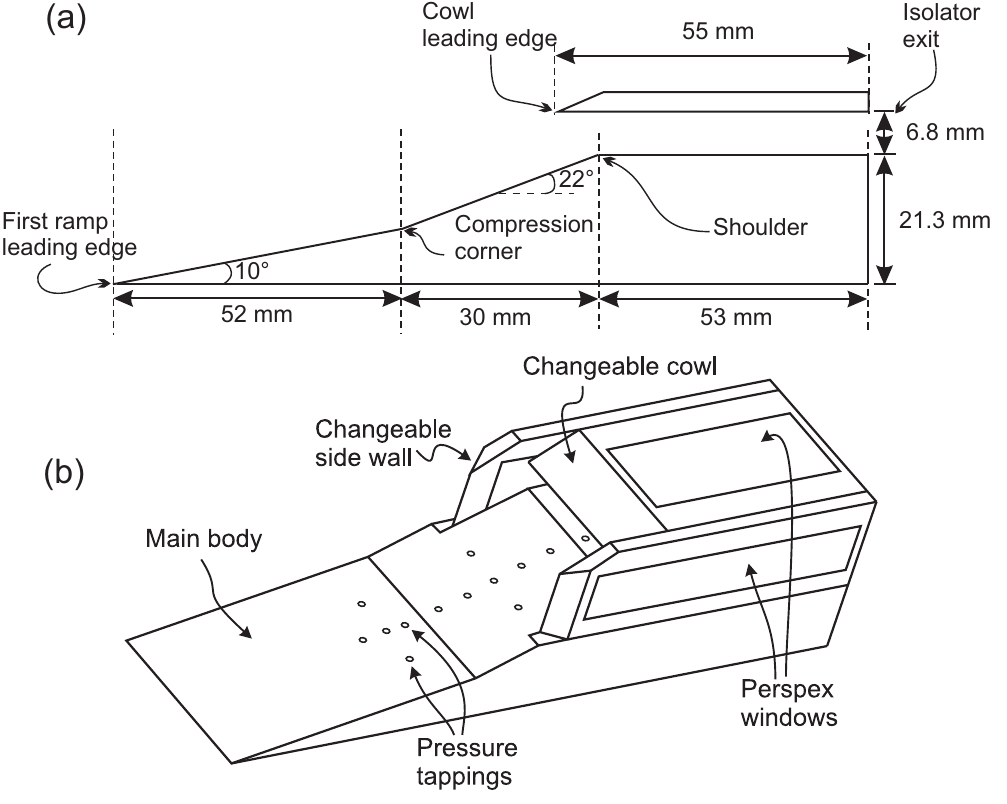
Figure 3. Basic dimension of the generic scramjet inlet-isolator.